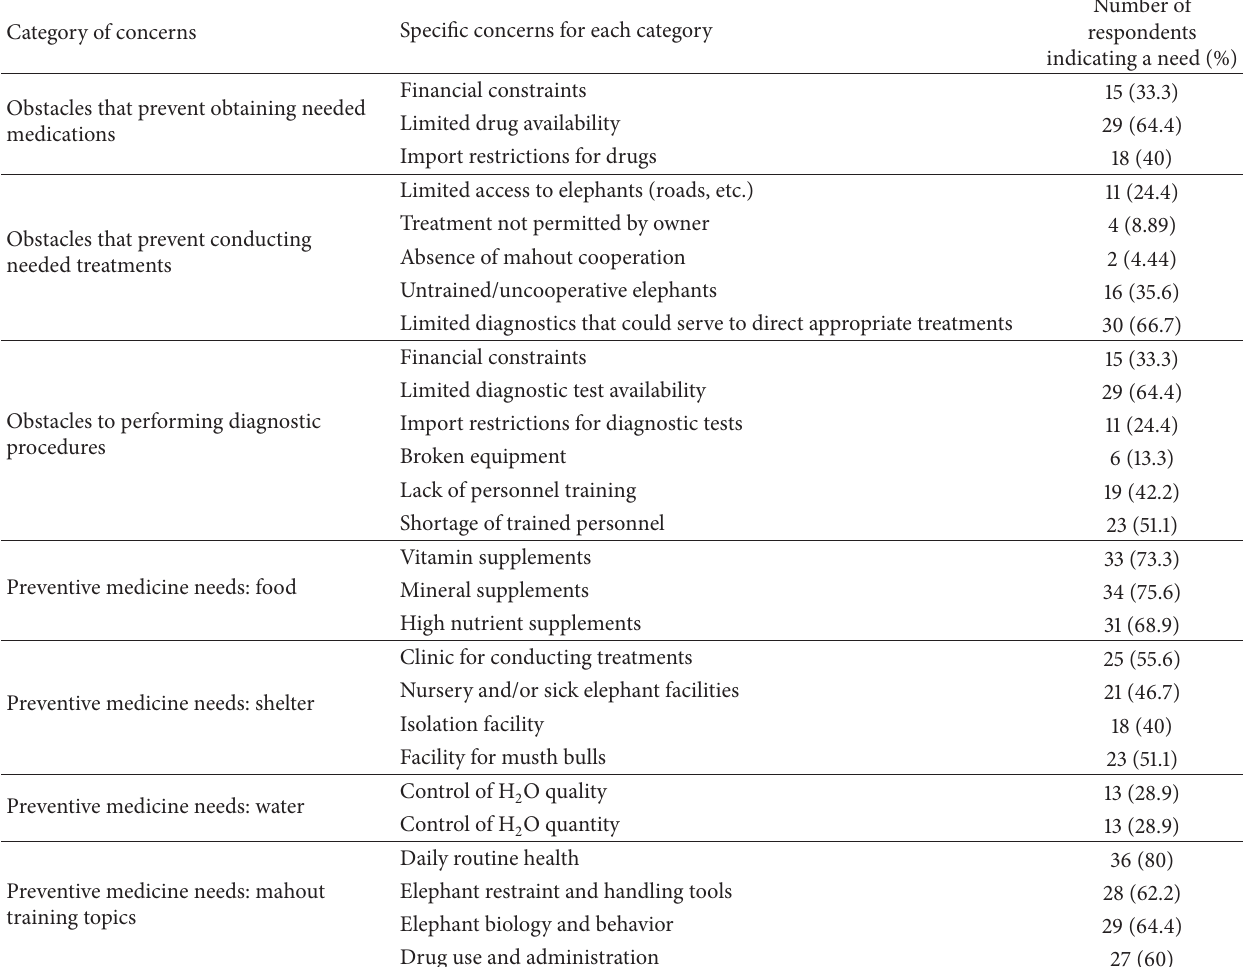
Table5:Surveyrespondents’( 𝑛 = 45 )perceptionsofneededimprovementsinthediagnosis,treatment,andpreventivemedicineforelephants in Asian range